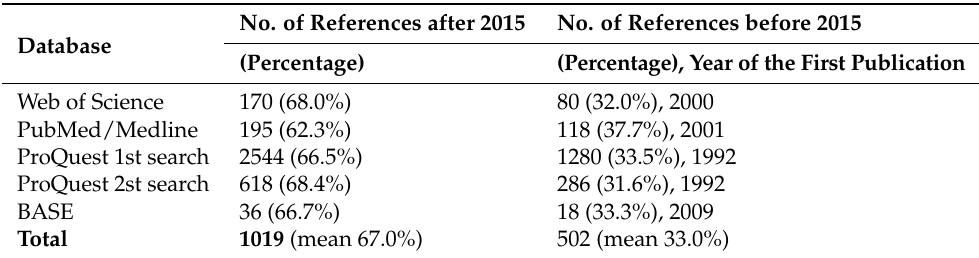
Table 2. Results of the string search in four